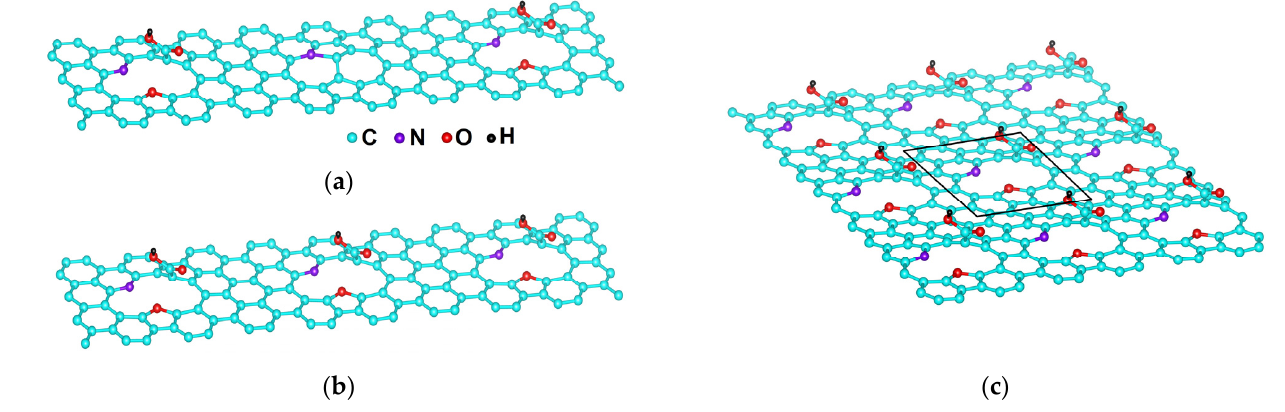
Figure 2. Cells of functionalized N-MWCNTs with ( a ) S1; ( b ) S2; and ( c ) S3 structures.